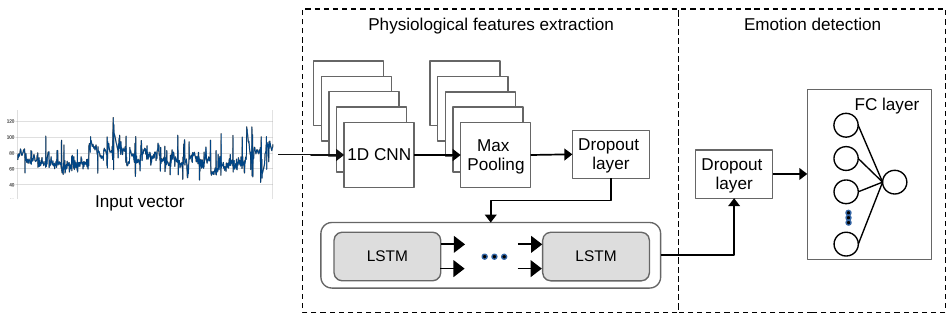
Figure 8. 1D CNN LSTM